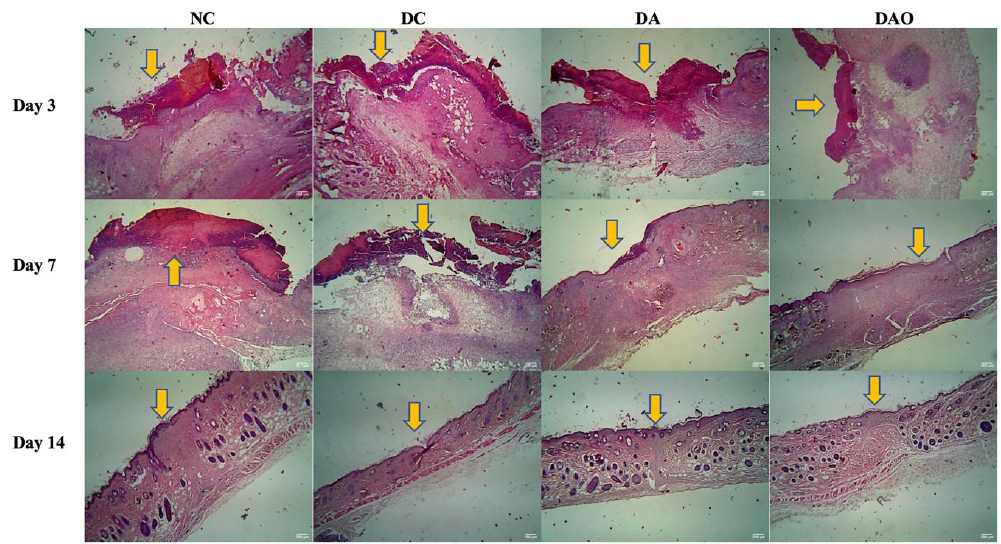
Figure 3. Histology of the wound width indicated by the yellow arrow. NC—normal control group;